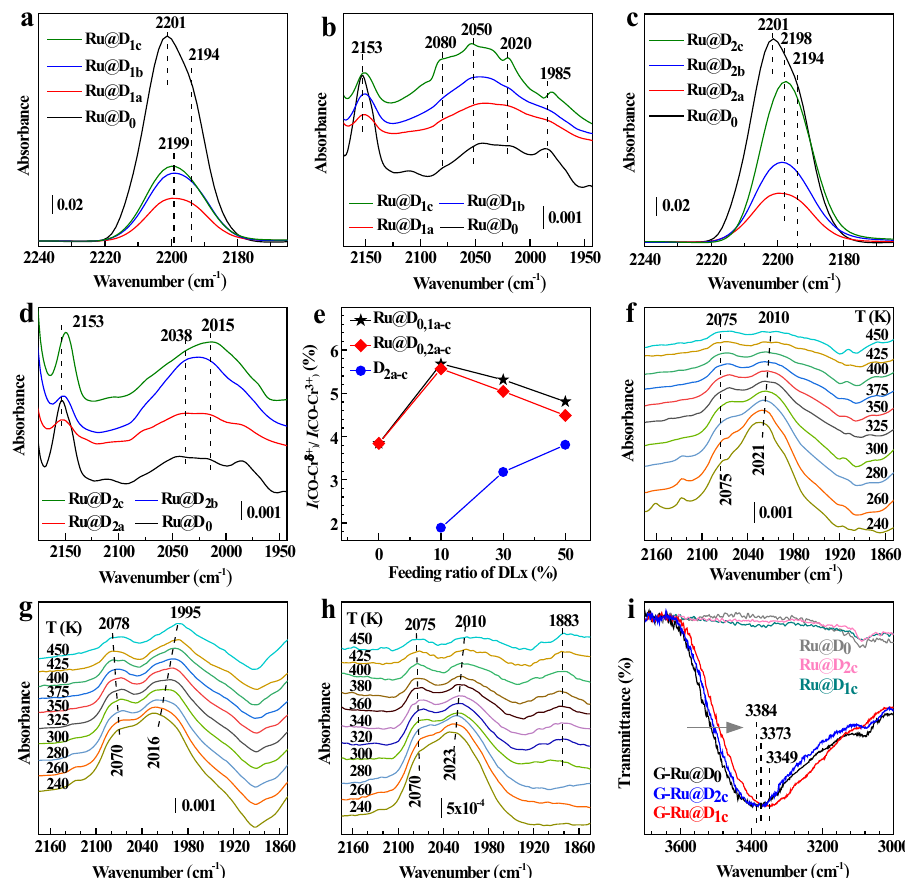
Fig. 3 Experimental con fi rmation of the modi fi cation of Cr-MSAS and con fi ned Ru NPs in Ru@DEMOFs by varying DLs type and concentration. a – d UHV-FTIR spectra obtained after CO adsorption (0.01 mbar) at ~110 K on Ru@D 1a-c ( a , b ) and Ru@D 2a-c ( c , d ) in different CO vibration regions. e Integrated intensity ratio of Cr δ + ( δ < 3)-related to Cr 3 + -related CO bands as a function of the doping level of DLx. For comparison, the UHV-FTIRS data of CO on Ru@D 0 is also displayed in a – d. f – h Temperature-dependent UHV-FTIRS data of CO on Ru@D 0 ( f ), Ru@D 1a ( g ), and Ru@D 2a ( h ). Prior to exposure, each sample was heated to 500 K to remove all adsorbed species. i Routine FTIR spectra of the D-glucose impregnated G-Ru@D 0 , G-Ru@D 1c , and G-Ru@D 2c , in comparison with the activated unloaded Ru@D 0 , Ru@D 1c , and Ru@D 2c